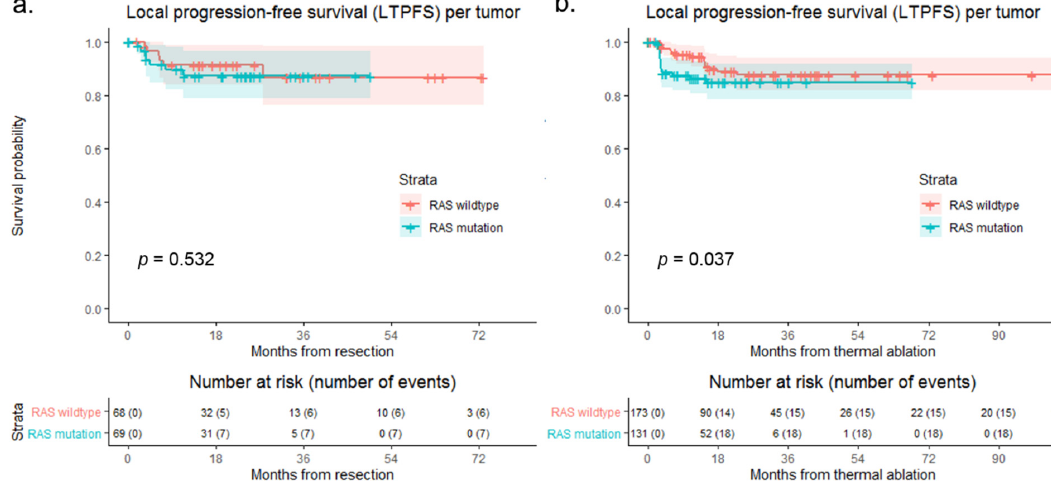
Figure 4. Kaplan–Meier curves with Gehan–Breslow–Wilcoxon test, of ( a ) local tumor progression-free survival (LTPFS) per tumor following resection ( p = 0.532) and ( b ) LTPFS per tumor following thermal ablation ( p = 0.037) comparing RAS wildtype (blue) to RAS mutation (pink). Numbers at risk (number of events) are per tumor. Death without local tumor progression (LTP; competing risk) is censored.